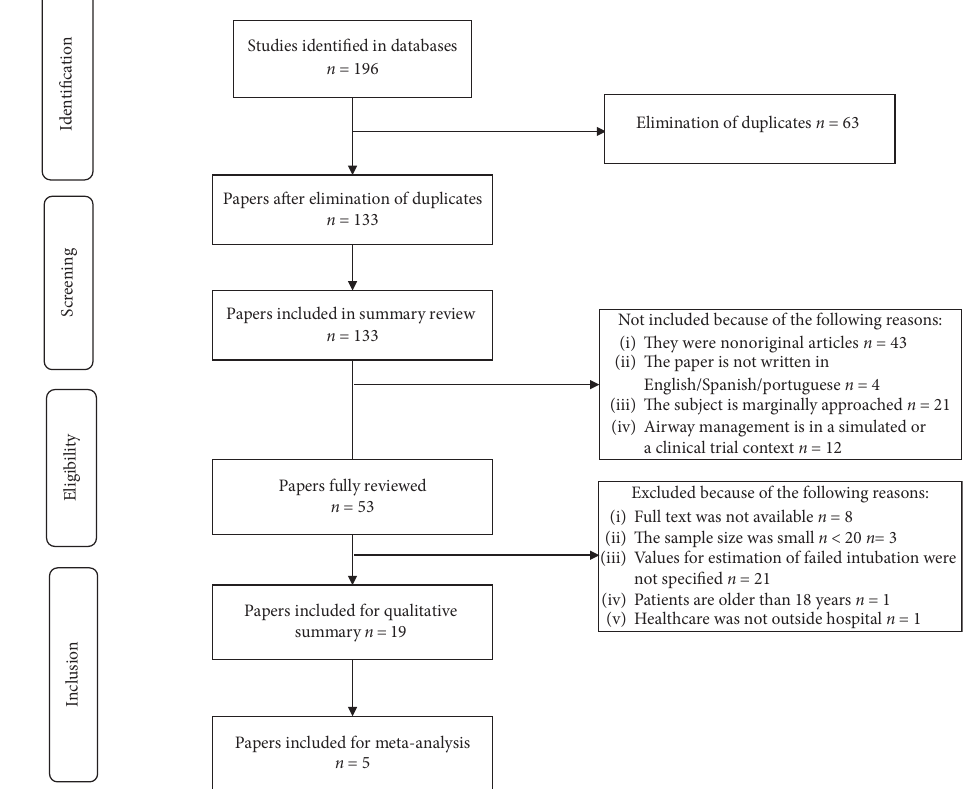
Figure 1: Flow diagram of study Table 1: Frequency of failed endotracheal intubation in each study.